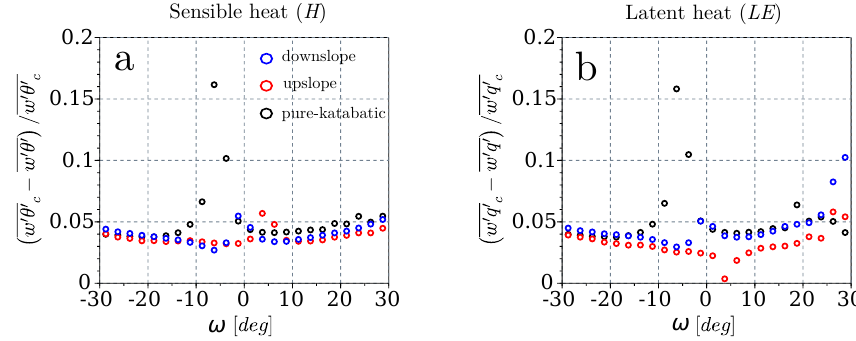
Figure 4. Relative difference between uncorrected covariances ( w (cid:48) x (cid:48) , x = θ,q ) and covariances corrected for transducer shadowing ( w (cid:48) x (cid:48) c ) for different attack angles and selected events inside each of the main wind-regime subsets. Results for (a) w (cid:48) θ (cid:48) and (b) w (cid:48) q (cid:48) during “pure- katabatic” (black), “downslope” (blue) and “upslope” (red) events are shown.